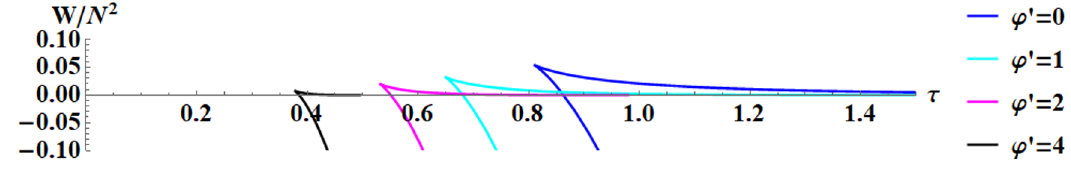
as function of BPS temperature τ for various ϕ 0 ≥ 0 . The values Figure 13 . The free energy W N 2 of ϕ 0 = 0 , 1 , 2 , 4 increase from right to left. The small black holes (the upper branch) have W = 0 at their maximal temperature τ (4.21) which is τ = 1 , 1 for ϕ 0 = 4 , 2 . The large black hole max max 2 branch is qualitatively similar to its analogue for ϕ 0 < 0 in figure